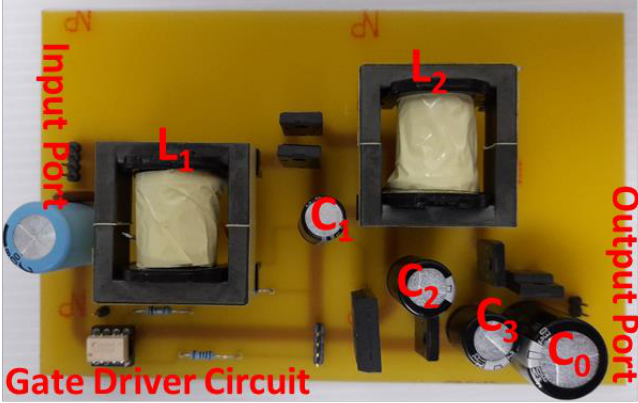
Figure 17. Proposed converter II hardware prototype.